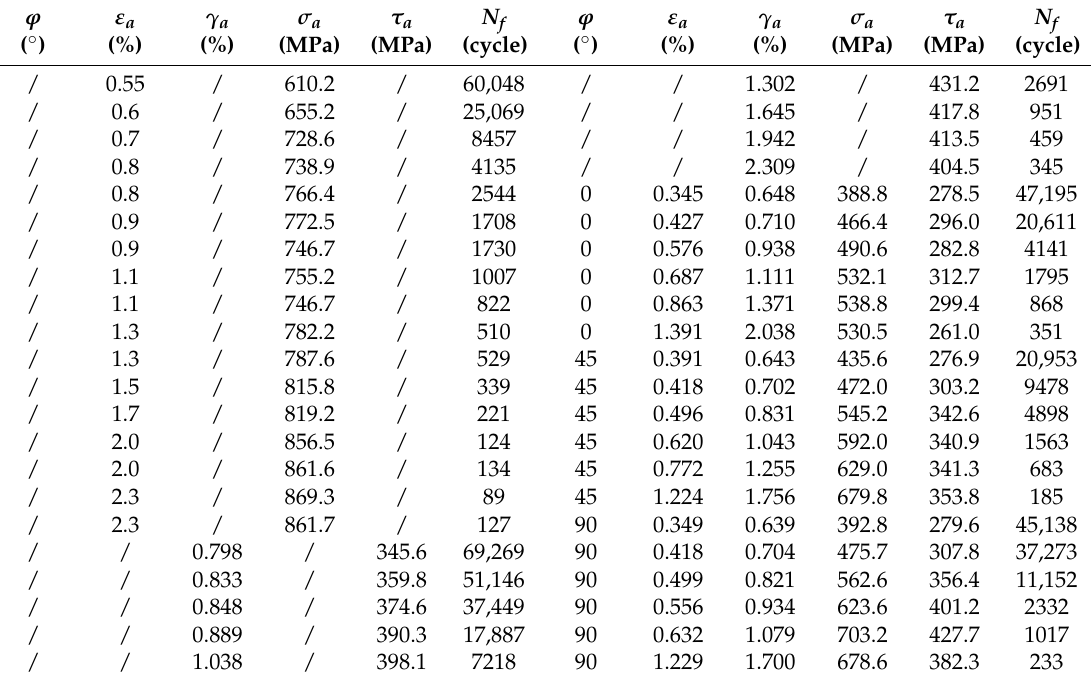
Table 3. The experimental data for TC4 under symmetric loadings.